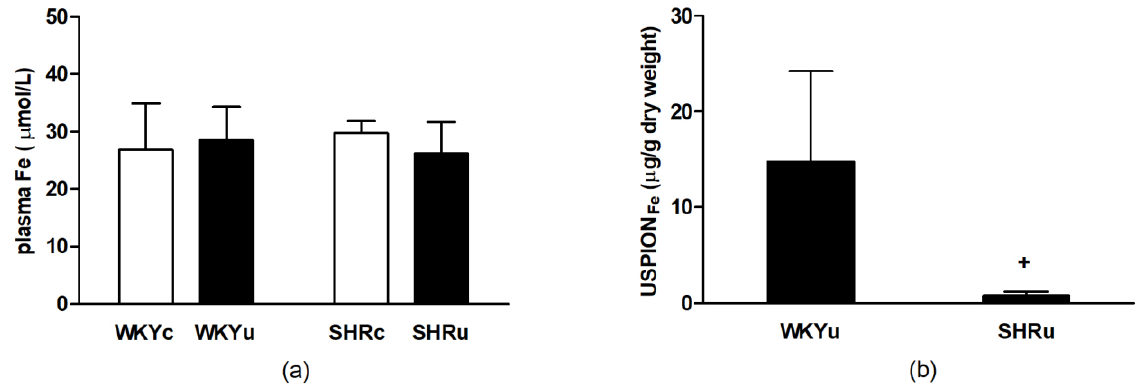
Figure 5. The effect of repeated USPIONs administration at the dose of 2 mg Fe/kg of body weight per day on total iron concentration in blood plasma ( a ) and USPION-originated iron content in RBCs ( b ). Rats were killed approximately 24 h after the second USPIONs administration. Abbreviations: USPIONs, ultra-small superparamagnetic iron-oxide nanoparticles; WKY, Wistar Kyoto rats; SHR, spontaneously hypertensive rats; WKYc, control WKY; WKYu, USPION-treated WKY; SHRc, control SHR; SHRu, USPION-treated SHR. Results are presented as mean ± SD, n = 6–7 per group ( a ), and n = 5 per group ( b ). + p < 0.05 vs. WKYu.